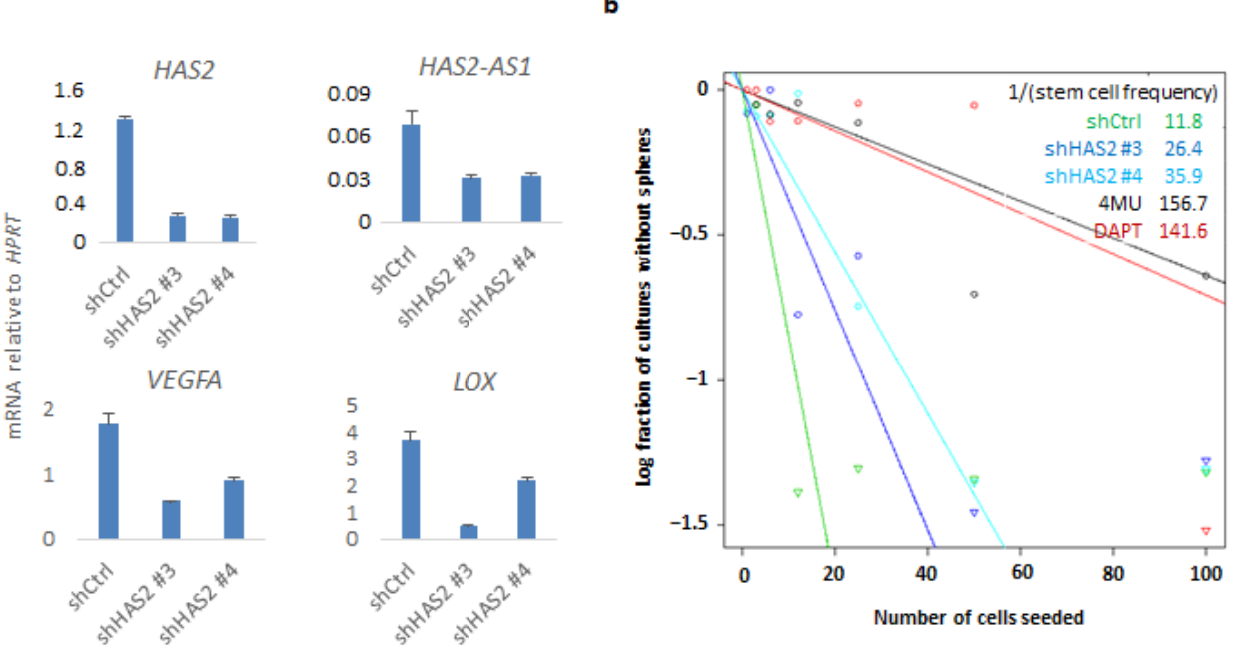
Figure 5. HAS2 downregulation impairs CD44-related genes and self-renewal capacity. ( a ) U251MG cells stably transfected with shRNAs against HAS2 or control shRNA were grown in sphere-like conditions. HAS2-AS1 , HAS2 , VEGFA , and LOX mRNAs were quantified by real-time qPCR analysis and normalized to HPRT . ( b ) An ELDA assay was carried out in the HAS2 knockdown and control cells, and cells treated with the hyaluronan synthesis inhibitor 4-MU or DAPT. One representative experiment out of two is depicted.